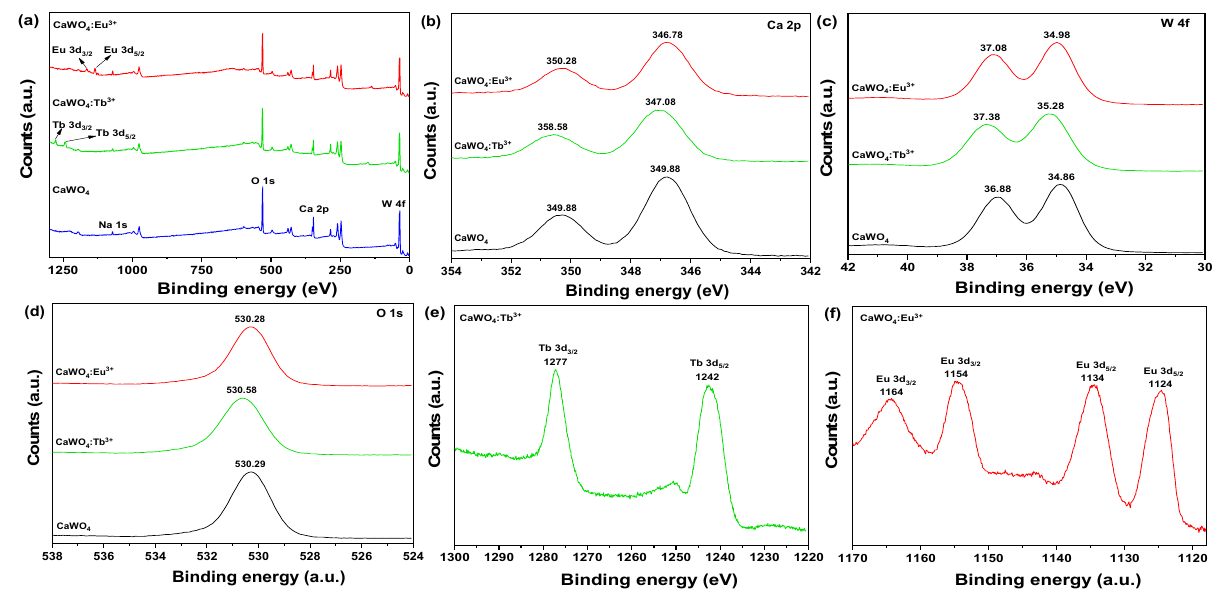
Figure 4. XPS spectra of ( a ) survey, ( b ) Ca 2p, ( c ) W 4f, ( d ) O 1s, ( e ) Tb 3d, and ( f ) Eu 3d. The peaks of Ca 2p had core binding energies of 346.78 eV (2P 3/2 ) and 349.88 eV (2P 1/2 ), indicating that Ca is in the +2 oxidation state [25]. At the peak of W 4f, the detected core binding energies were 34.86 eV (4f 7/2 ) and 36.88 eV (4f 5/2 ), which is considered to be the +6 state of W [26]. The peak of the binding energy of O 1s was detected as 530.29 eV, which is considered to indicate the crystal lattice oxygen with increasing binding energy 5b.